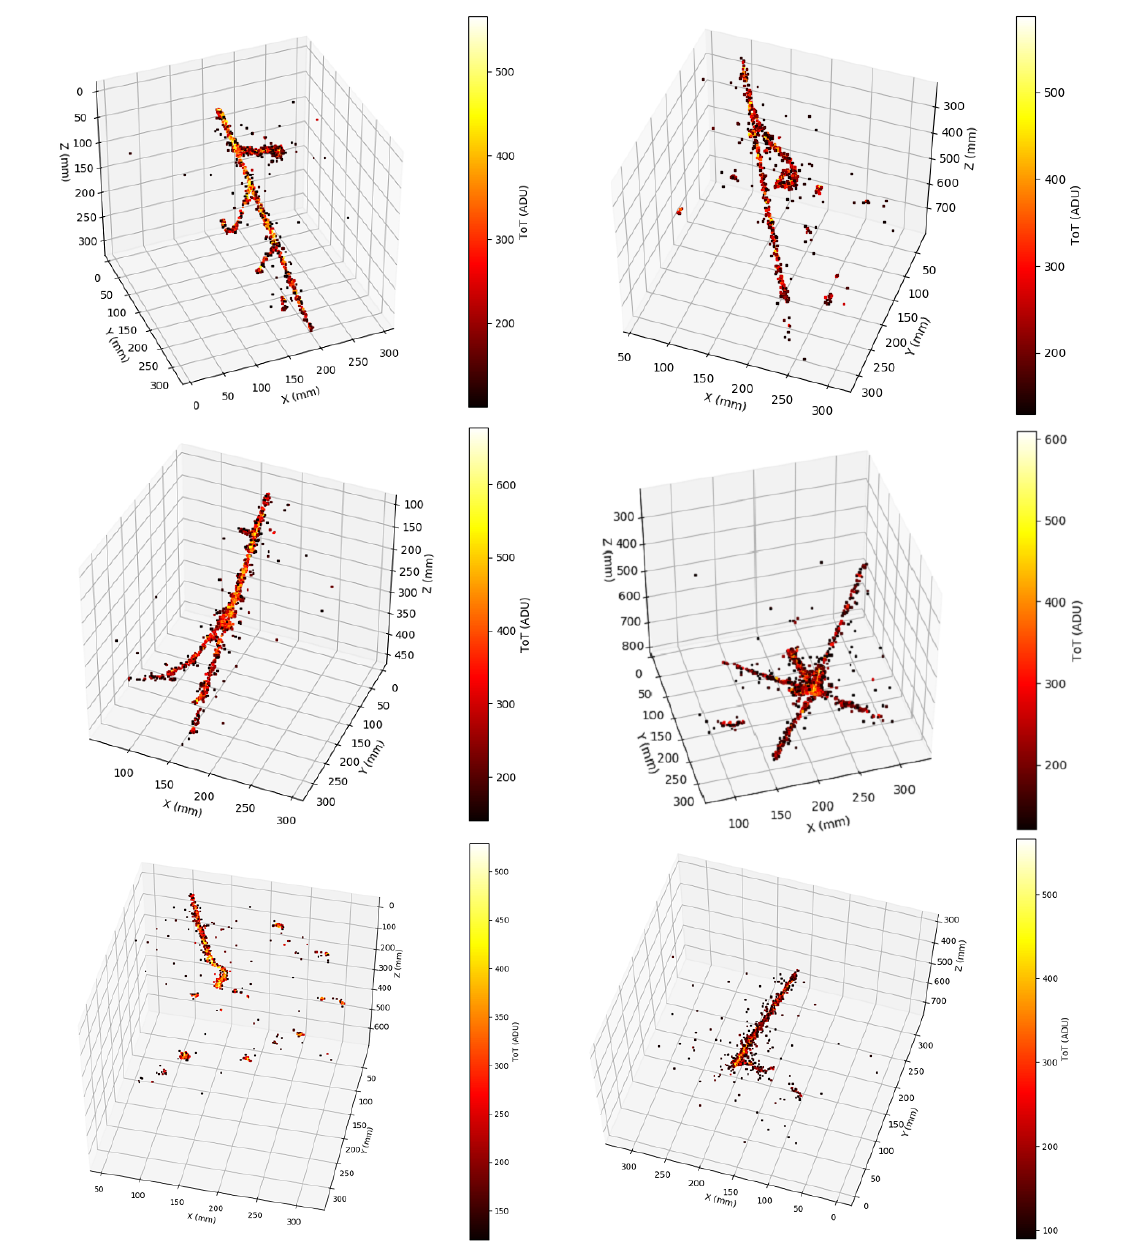
Figure 9. A selection of cosmic muon-initiated LAr interactions imaged by the ARIADNE TPX3Cam: long muon tracks with one or more deltas rays ( top row and middle-left ), an antiproton candidate ( middle-right ) and stopping muons with associated Michel electrons ( bottom row ). The colour bars indicate the hit ToT in